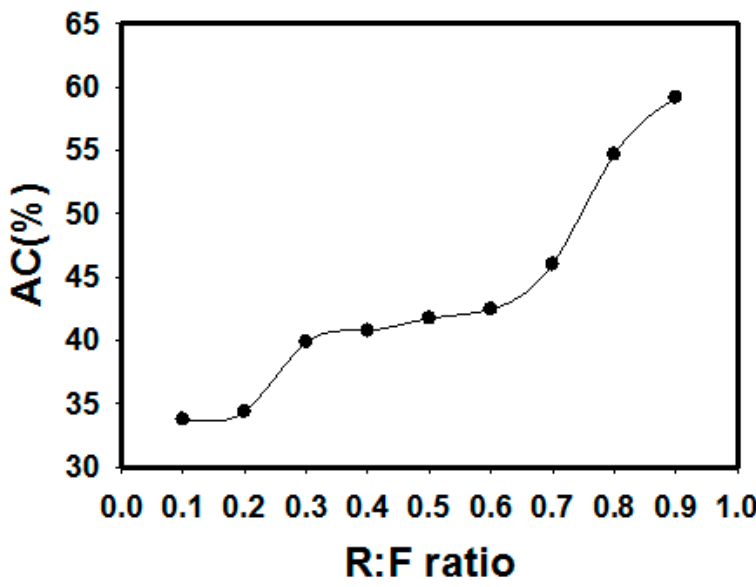
Figure 14. The yield of RFG n -AC production relative to the starting RFG n in terms of R:F ratios of the starting main reactants.